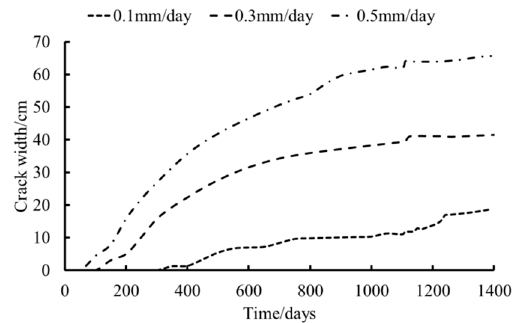
ff erent evaporation rates.